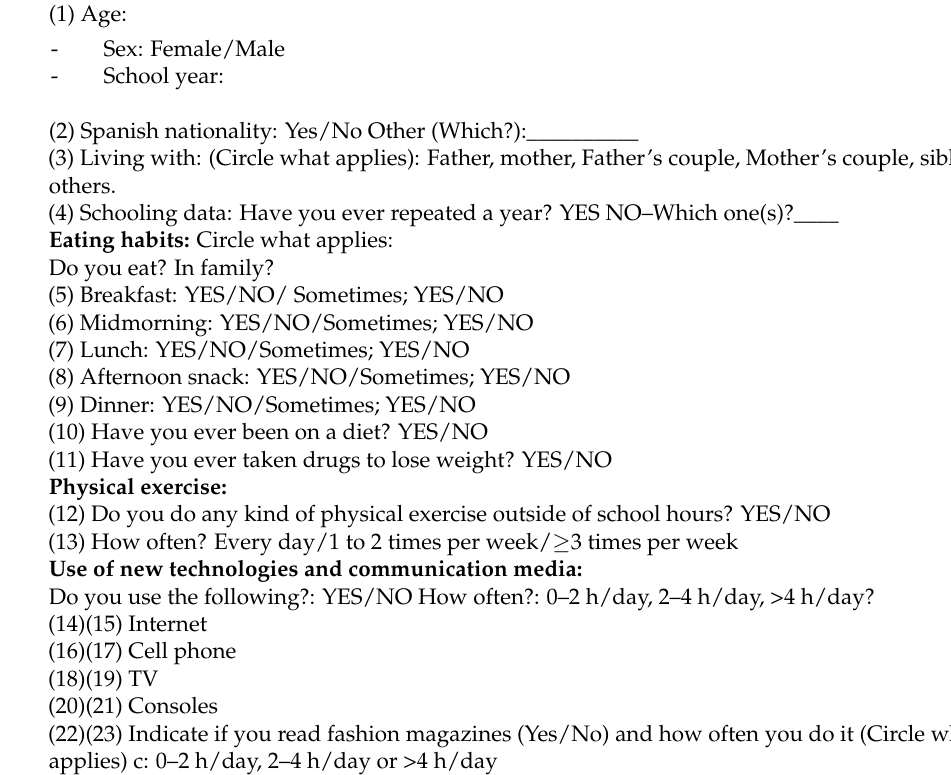
Table 1. Sociodemographic data and behavior variables